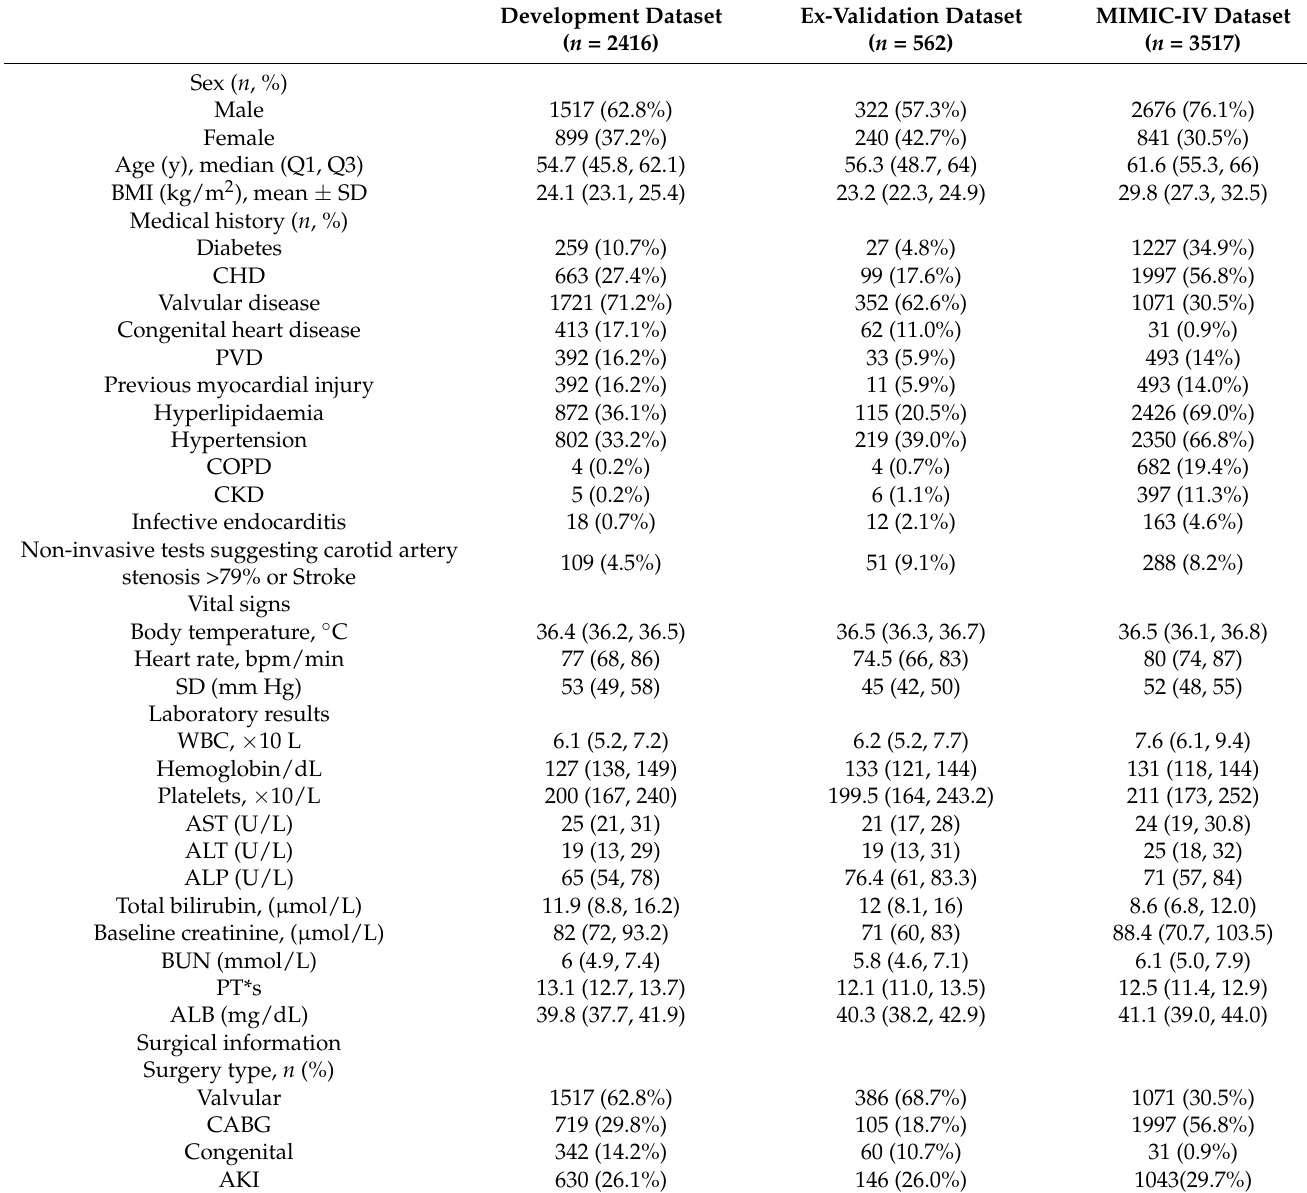
Table 1. Demographics of development and ex-validation